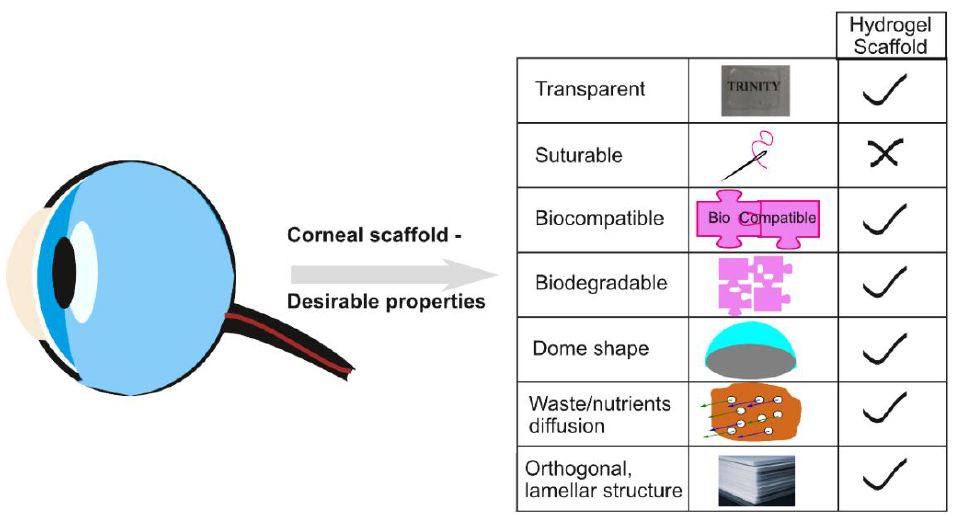
Figure 1. Schematic representation of desirable properties that hydrogels should possess for cor- neal tissue engineering. tissue